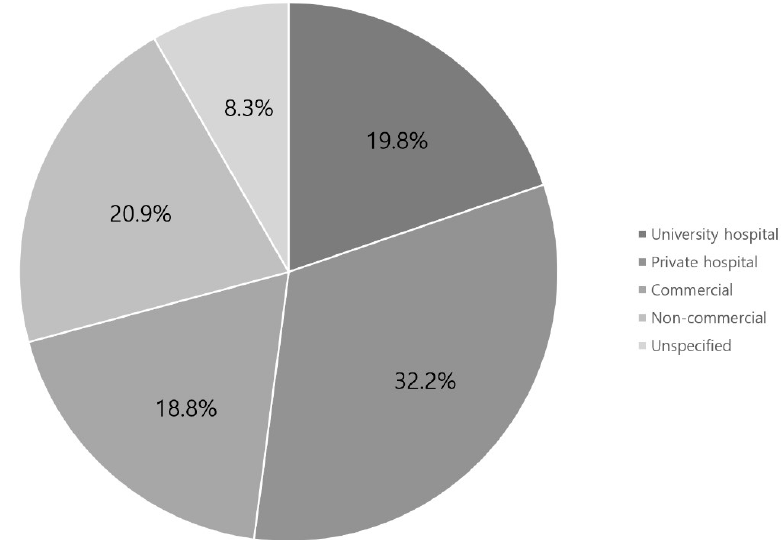
Figure 2. Summary of websites by website authors.